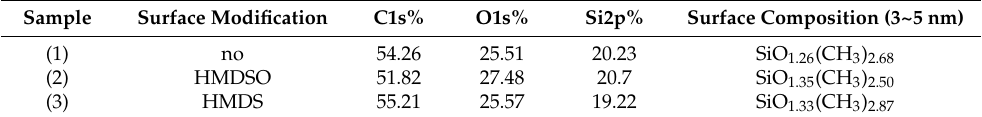
Table 1. Atomic percentage of flexible MSQ aerogels without or with modifications calculated by XPS.